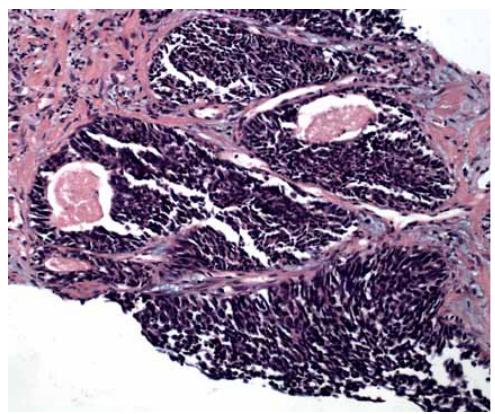
Figure 5 - Small cell carcinoma. Punctuate tumor necrosis is a common finding. Also note the desmoplastic stroma surrounding tumor nests. Hematoxilin-eosin, 200x.